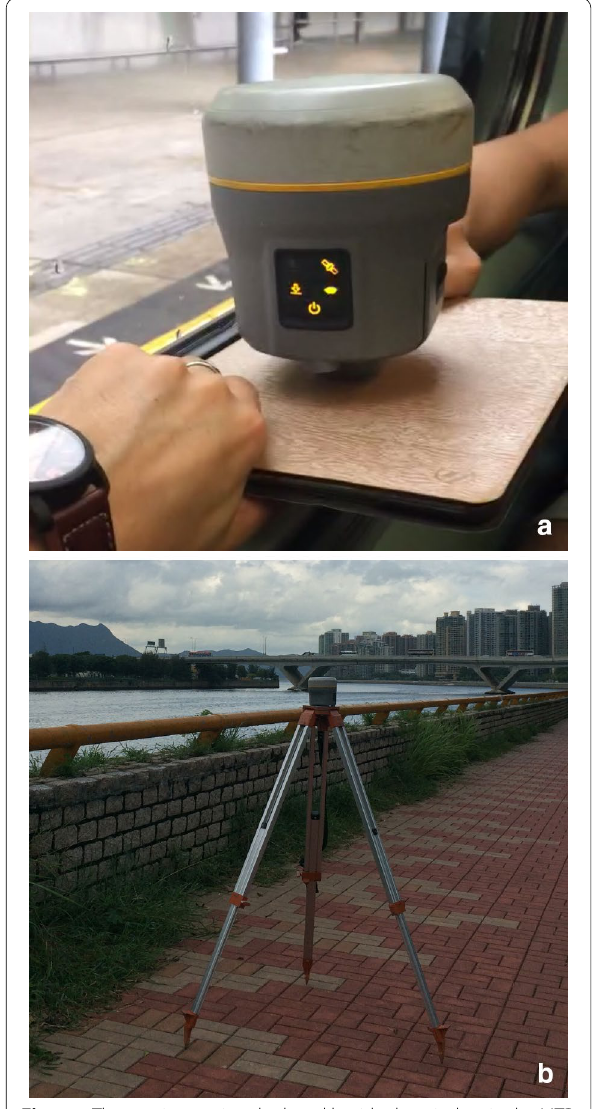
the Tai Shui Hang Station or southbound from the Tai Shui Hang Station to the Shek Mun Station, the MS receiver was always put at the same side where the SS receiver is located (left side in Fig. 2). The data was collected for around 80 min from 15:08 to 16:28 Hong Kong Time (HKT) on 19 June 2017. It took the MTR train approximately 5 min to run between the two stations and one data file was gener- ated for each journey. Ten sets of GNSS data were recorded by the MS receiver, but four of them were not used in this study due to their poor data quality. The poor data quality